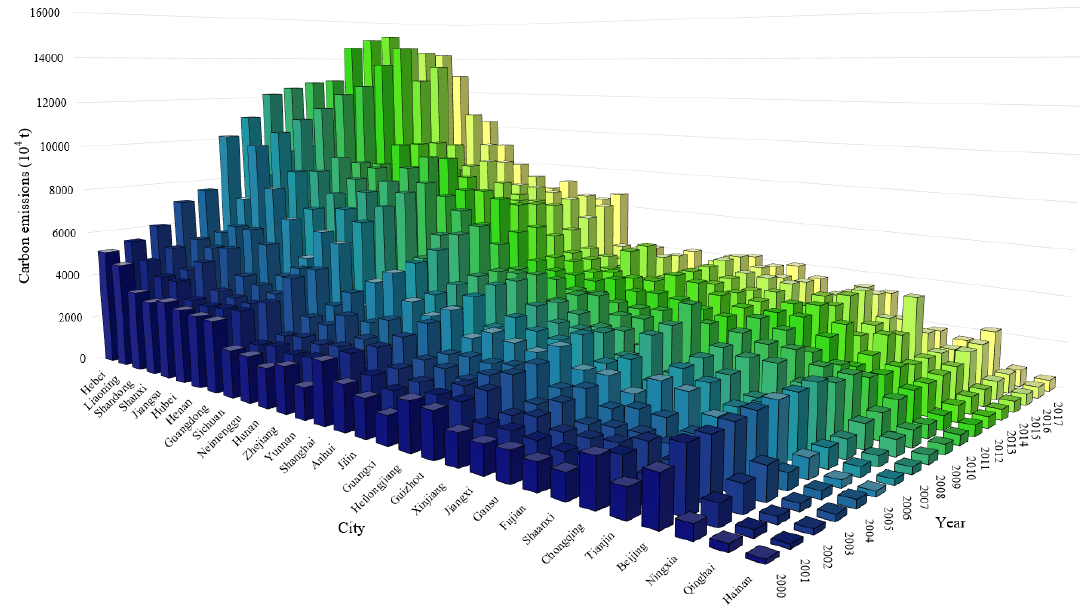
Figure 3. Bar diagram of statistical carbon emissions at the provincial level for the periods 2000– 2017.